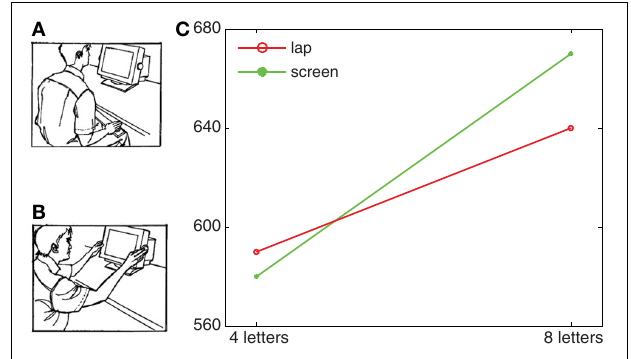
FIGURE 1 | Lap posture (A) and screen posture (B) as employed by Abrams et al. (2008) and an exemplary pattern of response time results (C). Parts (A) and (B) reproduced from Figure 1 of Abrams et al. (2008).